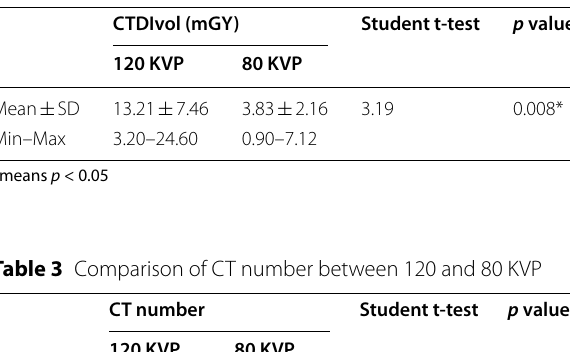
Table 2 Comparison of CTDI (mGy) between 120 and 80 KVP vol